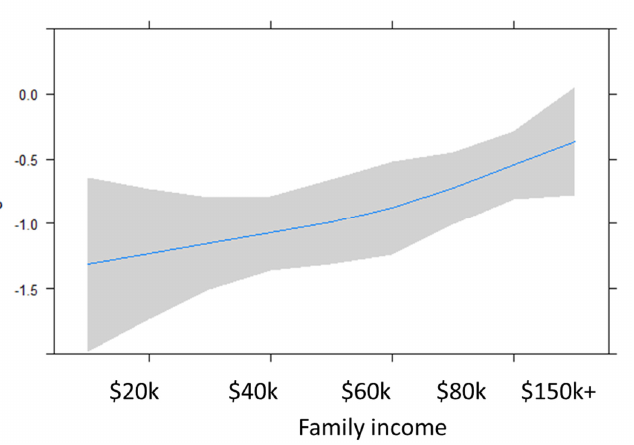
Figure 1. Spline model depicting the risk of ALS by family income ( p = 0.00030). Blue line represents the log odds and the grey shading depicts the 95%